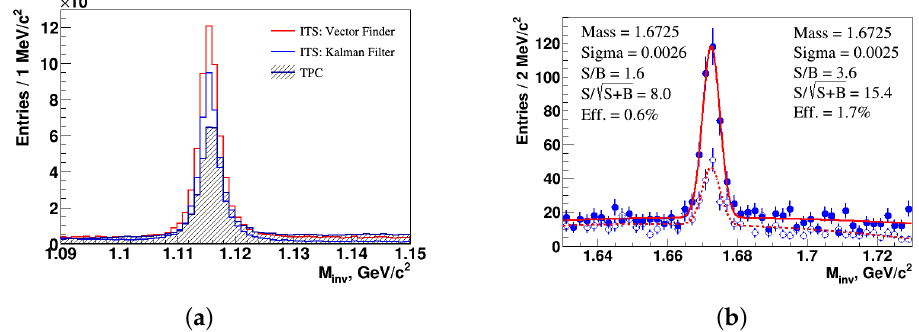
Figure 8. ( a ) Reconstructed invariant mass spectra of Λ hyperon decay products: Λ → p + π − . Red, blue and hatched histograms show results from the Vector Finder, Kalman filter track follower and TPC-only reconstruction, respectively. ( b ) Reconstructed invariant mass spectra of Ω hyperon decay products: Ω → Λ + K − . Filled and empty symbols present results for TPC and TPC–ITS configurations. Histograms are fitted to a sum of a gaussian and a polynomial functions. The numbers in the legends present the mean and sigma of the gaussian as well as the signal/background ratio, significance and signal reconstruction efficiency, and efficiency is taken with respect to all hyperons produced within 50 cm of the interaction point. Left and right legends are, respectively, for TPC and